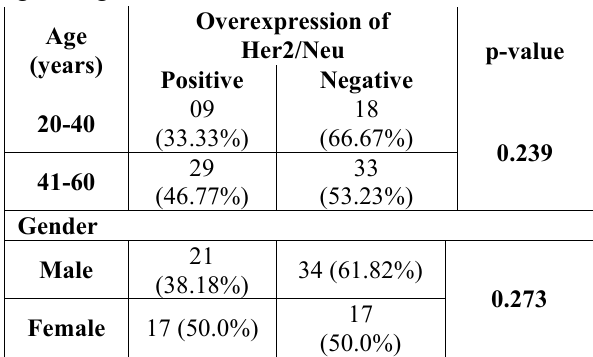
Table-3: Stratification of over expression of Her2/Neu with respect to age & Gender groups.